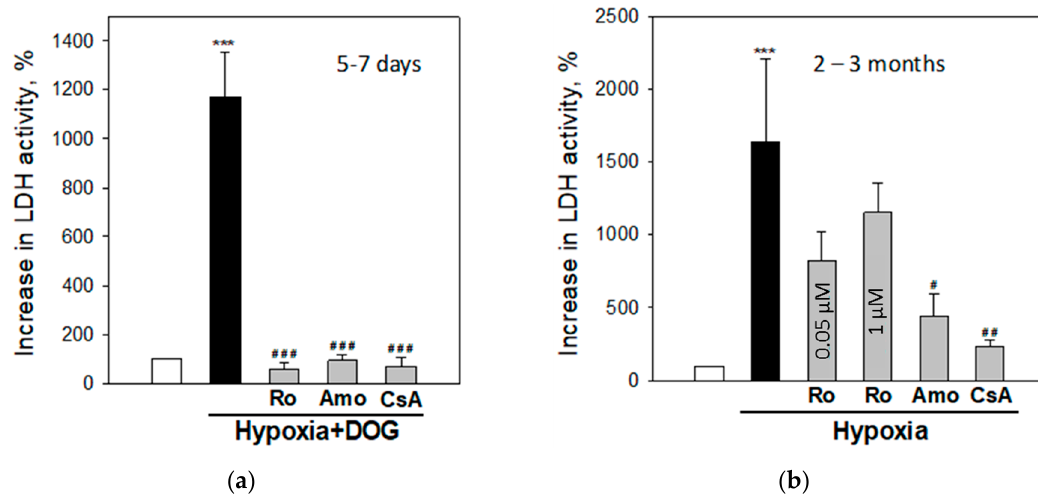
Figure 6. The effect of mitochondrial respiratory Complex I and mitochondrial permeability transition pore (MPTP) inhibitors on the level of simulated ischemia-induced necrosis in brain slice cultures from 5–7 days ( a ) and 2–3 months old ( b ) rats. Where indicated, 0.05 µM or 1 µM rotenone (Ro), and 2.5 mM amobarbital (Amo), and 0.5 mM cyclosporin A (CsA) were added to slice culture incubation medium before the start of simulated ischemia as described in Methods. The level of necrosis in slice cultures was evaluated by measuring increase in LDH activity in slice culture medium. The data were normalized against normoxic controls of each age group assuming that normoxic level is 100% (white bars) and presented as mean + standard error. N = 3–7; ***—statistically significant di ff erence compared with normoxic control of the corresponding group, p ≤ 0.001. ###, ## and #—statistical significance compared to hypoxia + DOG or hypoxia treatment, p ≤ 0.001, p ≤ 0.01 and 0.05, respectively.